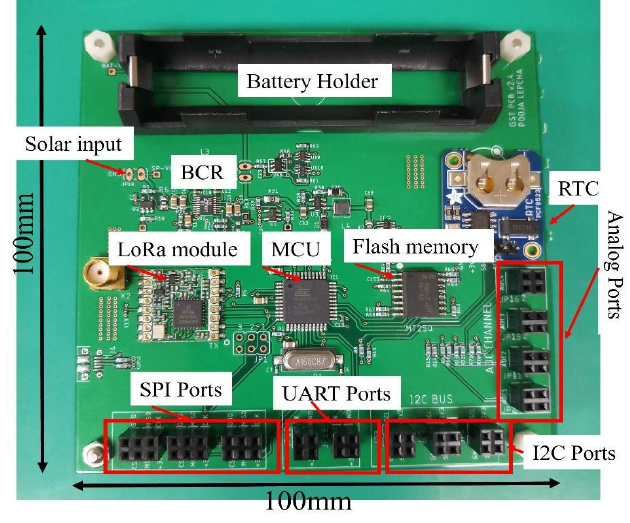
Figure 8. PCB design of GST.